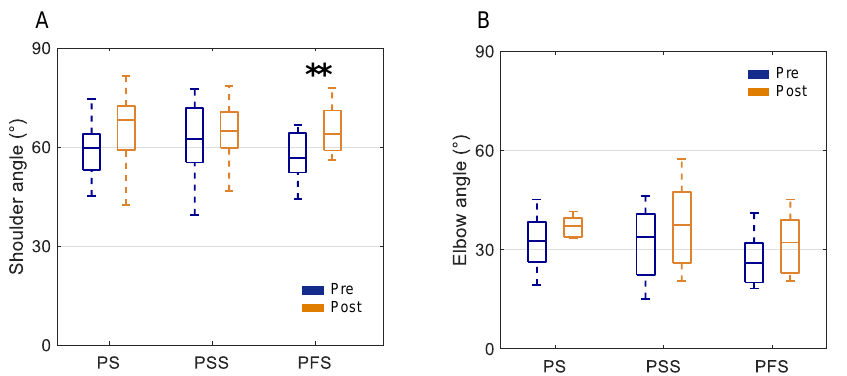
Figure 4. Boxplots showing the median and IQR of the shoulder ( A ) and elbow ( B ) angles calculated before and after the training program. PS: penalty shot; PSS: passing-spontaneous shot; PFS: passing-feint shot. Statistically significant differences between the Pre and Post conditions are highlighted with asterisks (** represents a p -value < 0.01).